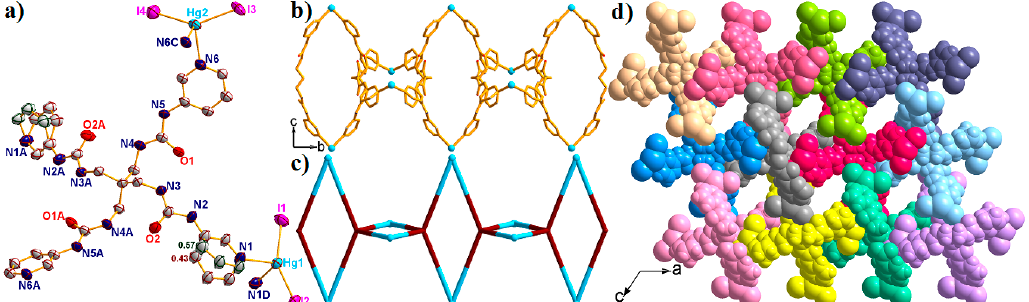
Figure 6. ( a ) The asymmetric unit of complex 5 with 50% probability ellipsoids. (Symmetry codes: A: − x , y , 1 − z ; C: x , 2 − y , z ; D: x , 3 − y , z ). The 1D [Hg 2 L] n polymeric chain ( b ) and the 1D simplified structure ( c ) viewed along the a direction. ( d ) Space filling 3D supramolecular structure of 5 viewed along the b direction. All solvents have been omitted for